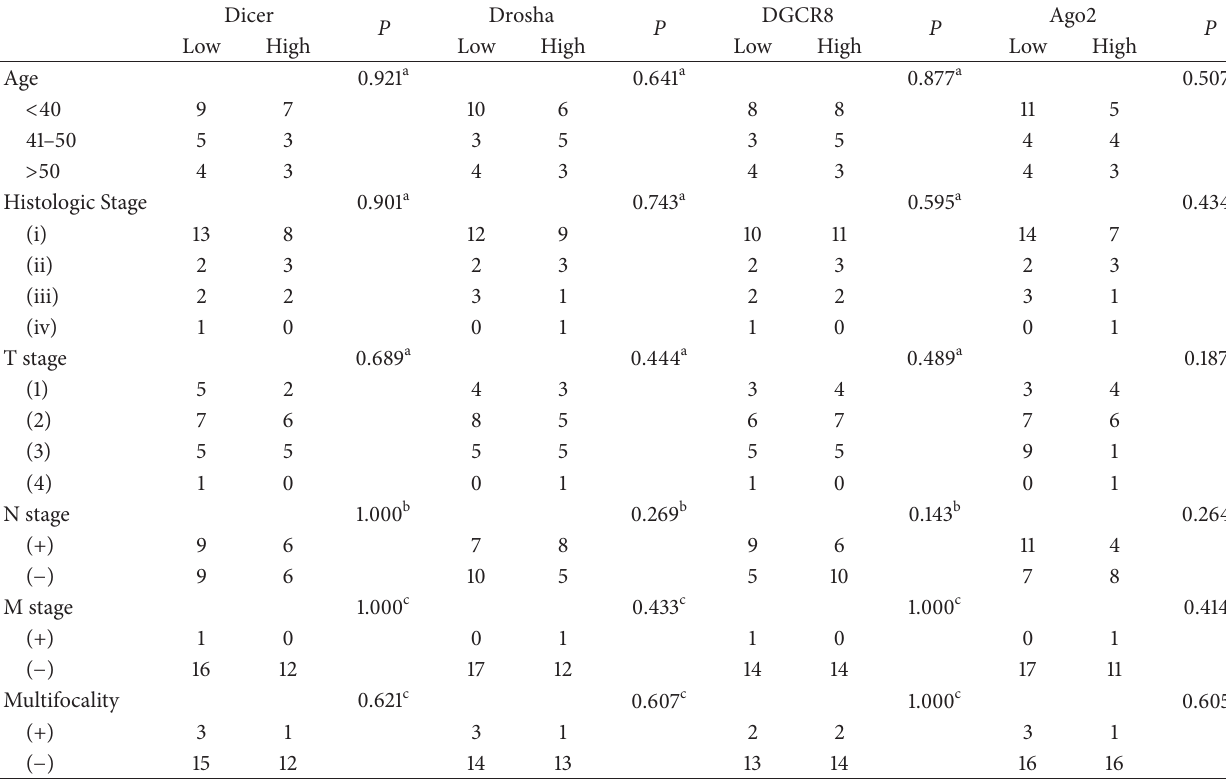
a Linear by linear association. b Chi-squared test. c Fisher’s Exact